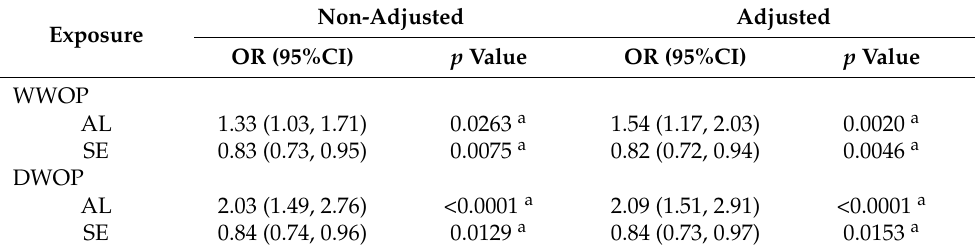
Table 2. Associations of AL and SE with DWOP and WWOP.